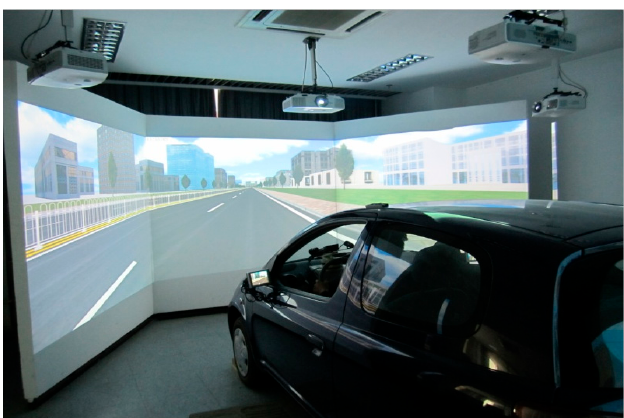
Figure 1. Driving